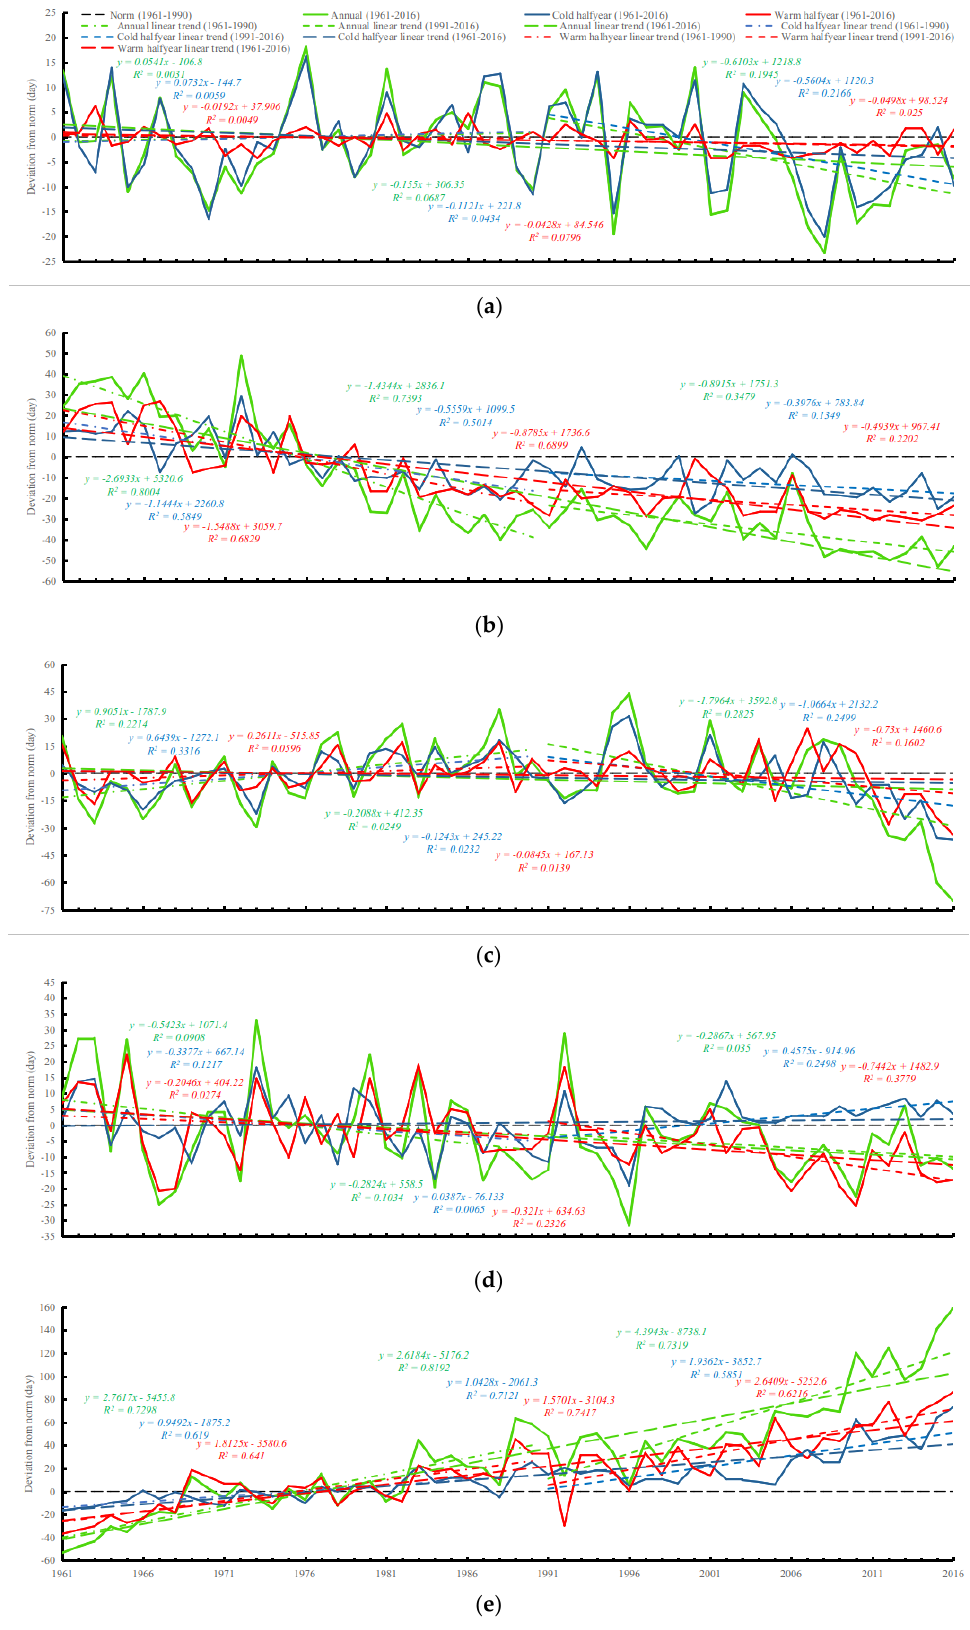
Figure 8. Deviation from the climate normals of the baseline period 1961–1990 of the total cumulative duration of SWT 1, 2, 3 ( a ), 5, 6, 7 ( b ), 9, 9a, 9b ( c ), 10 ( d ), 12, 13 ( e ). In order to assess changes to the total duration of the group of southern cyclones types 1, 2, and 3, trends of their cumulative total duration of the baseline (1961–1990) and present climatic periods (1991–2016) were calculated (Figure 8a). There was a small variation in trends in the baseline period,